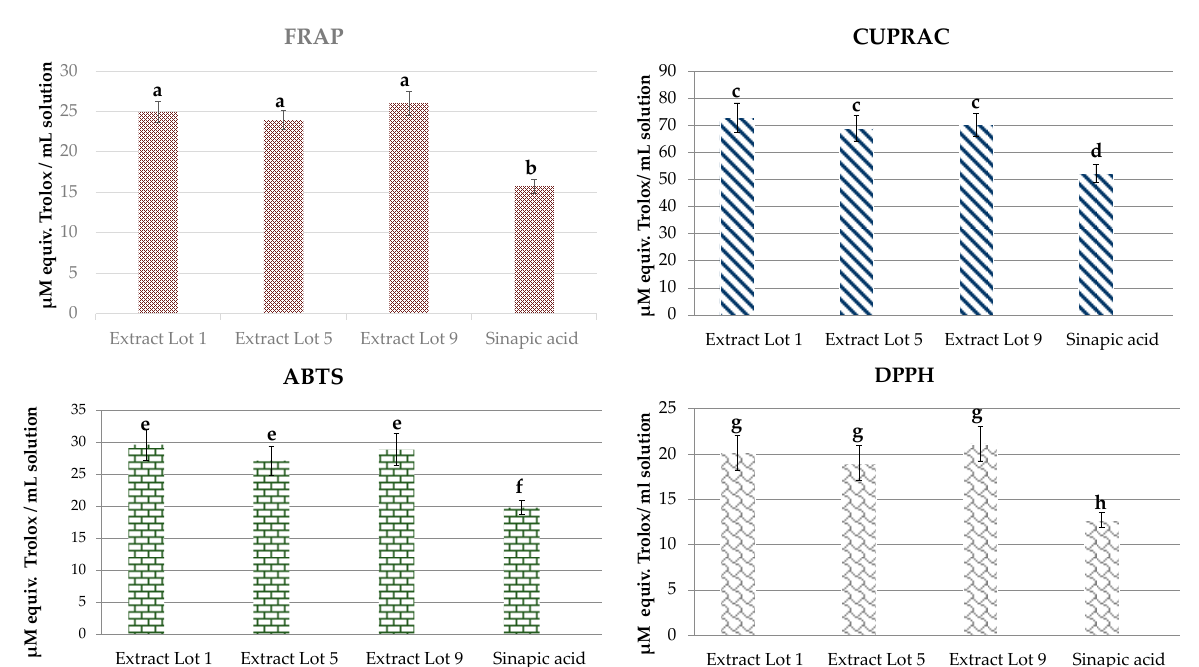
Figure 2. Antioxidant (FRAP, CUPRAC, ABTS, DPPH) activities of ethanolic extracts from RSM lots. Solutions normalized to 1% polyphenols, compared with the solution of 0.85% sinapic acid. The values presented represent means ± standard errors ( n = 5). Columns labeled with different letters within each type of antioxidant activity are significantly different at p < 0.05.